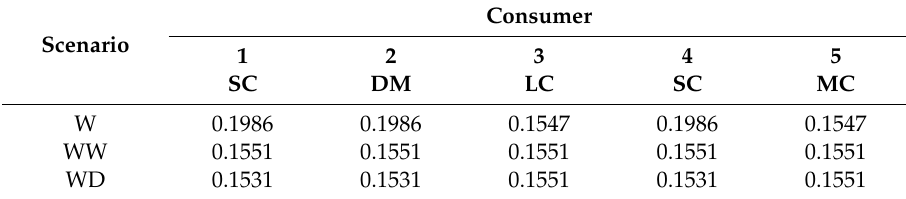
Table 9. Remuneration tari ff